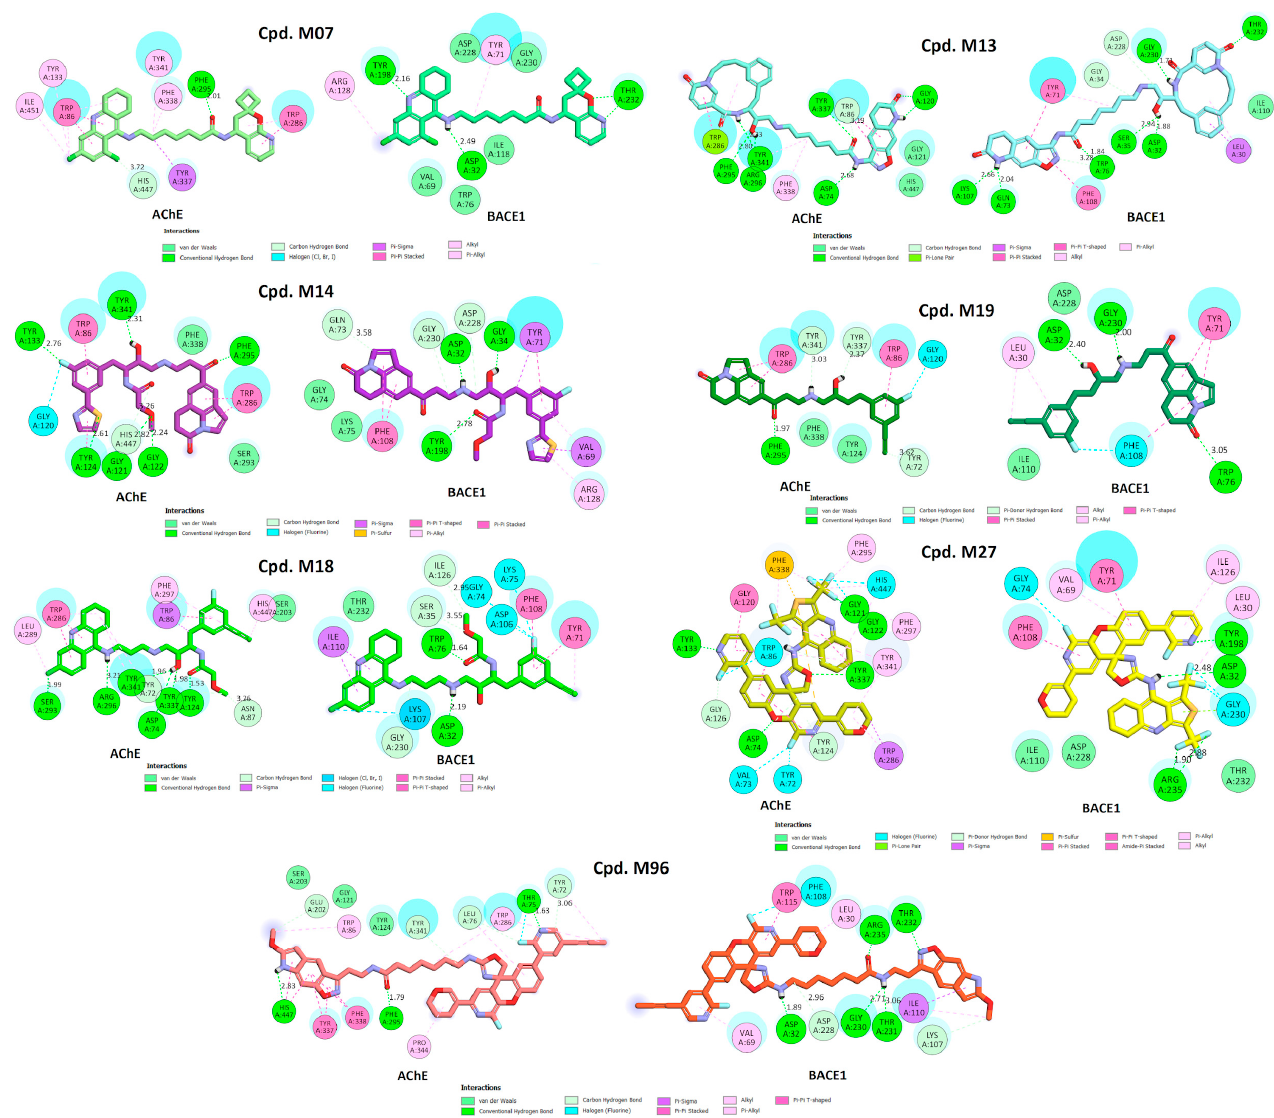
Figure 10. Two-dimensional interactions of designed compounds with residues of the active sites of AChE and BACE1.